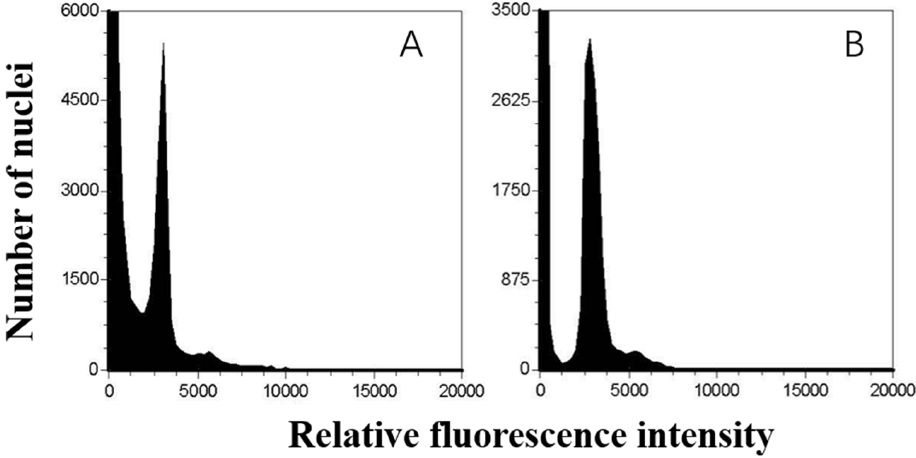
Figure 1. Histograms of the DNA contents of Populus trichocarpa ( A ) and Ziziphus jujuba “Dongzao” ( B ).